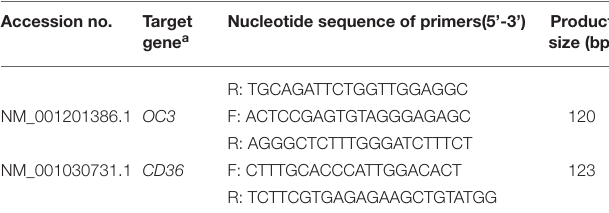
TABLE 2 | Sequence of primers for real-time